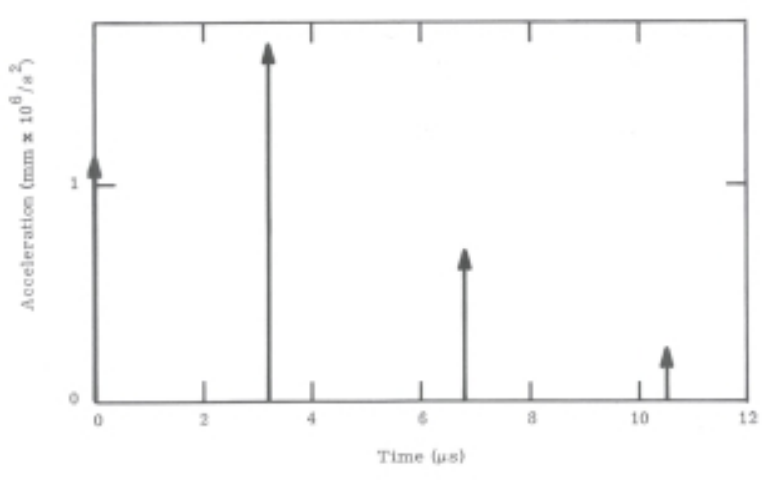
Fig. 5. Acceleration versus time of loaded surface of aluminum plate interacting with